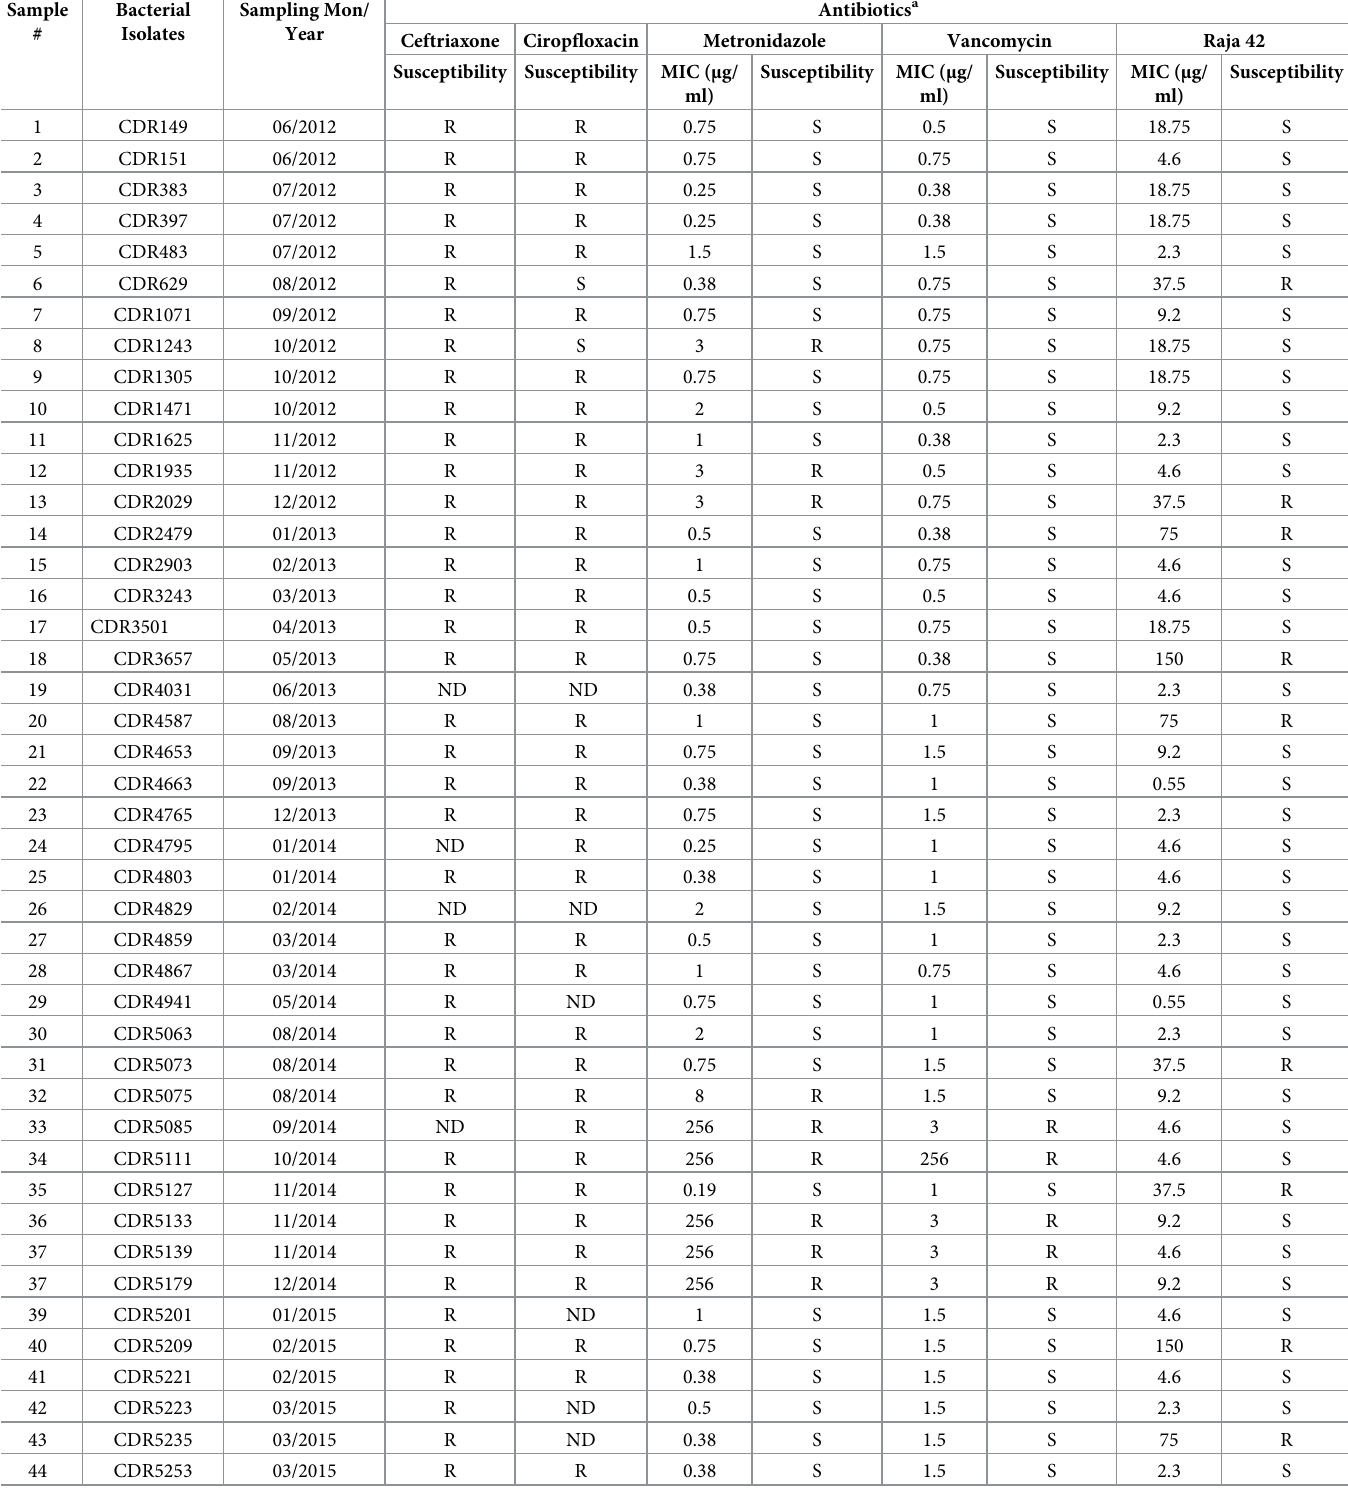
Table 1. The effets of Raja 42 on 60 C . difficile